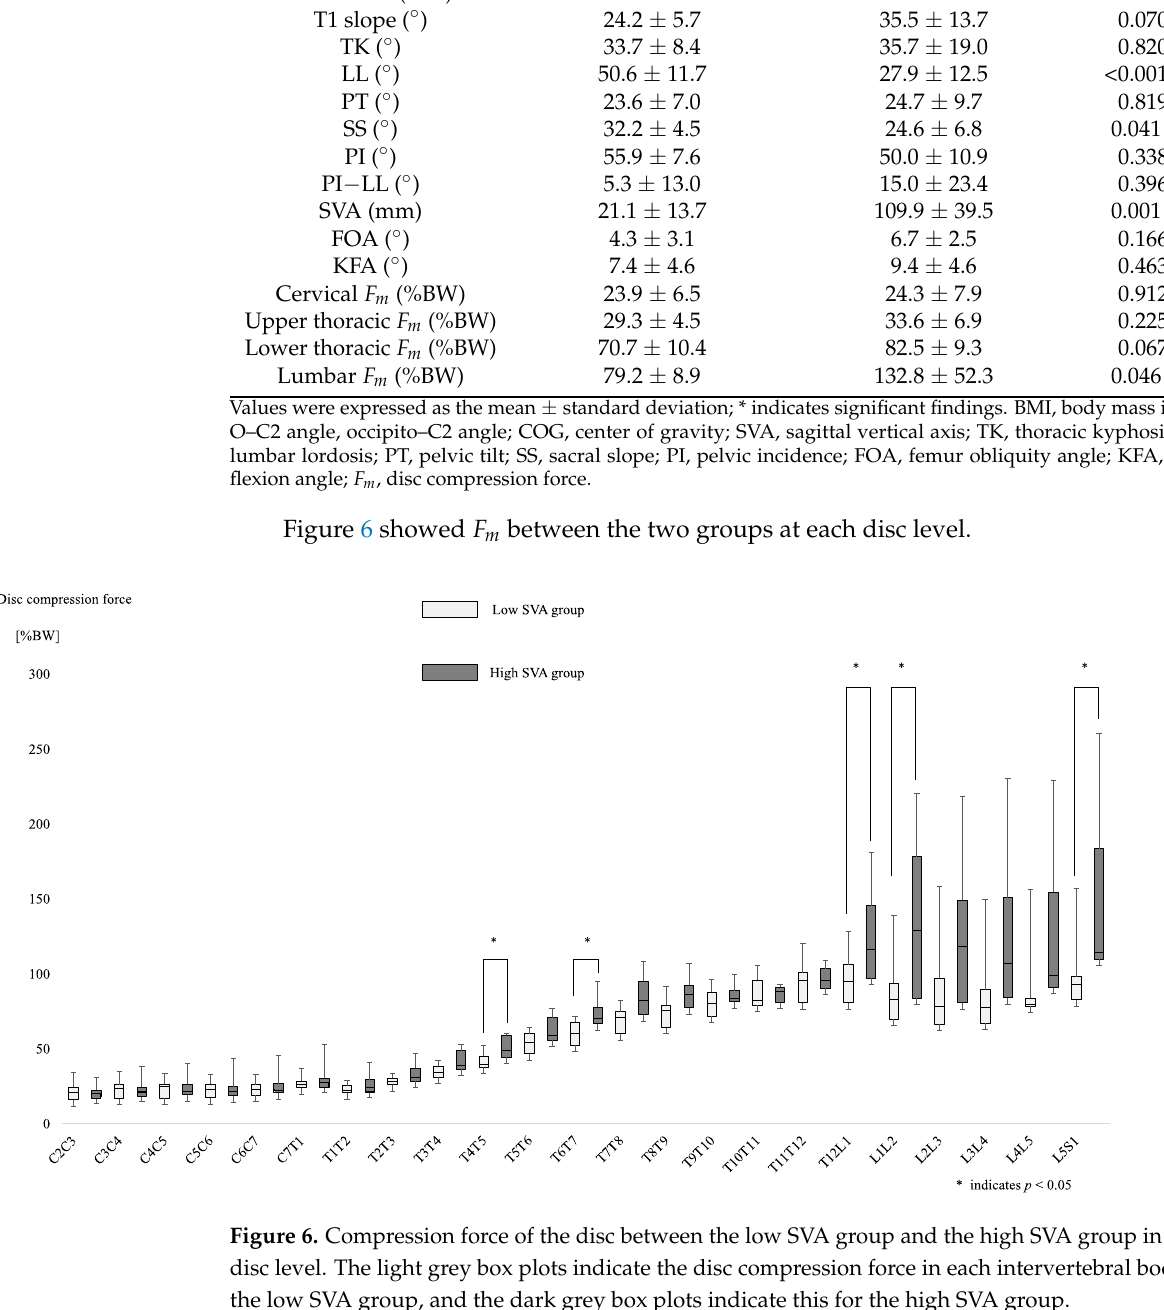
Table 2. Comparison of the low SVA and high SVA groups.